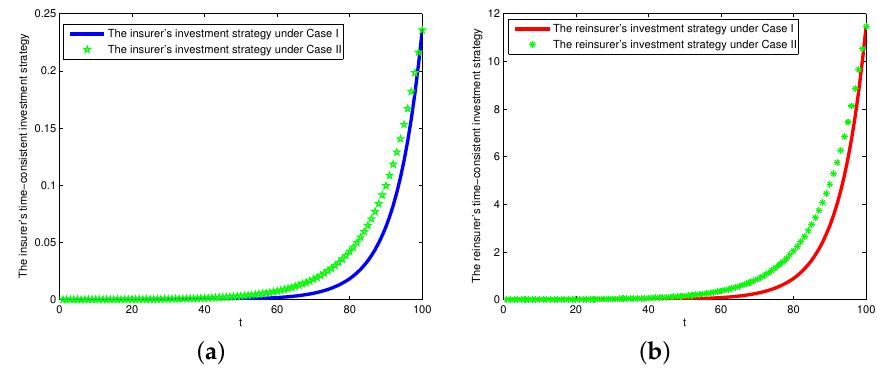
Figure 3. Nash equilibrium investment strategies for ( a ) the insurer and ( b ) the reinsurer ( α = 0.8 and x =